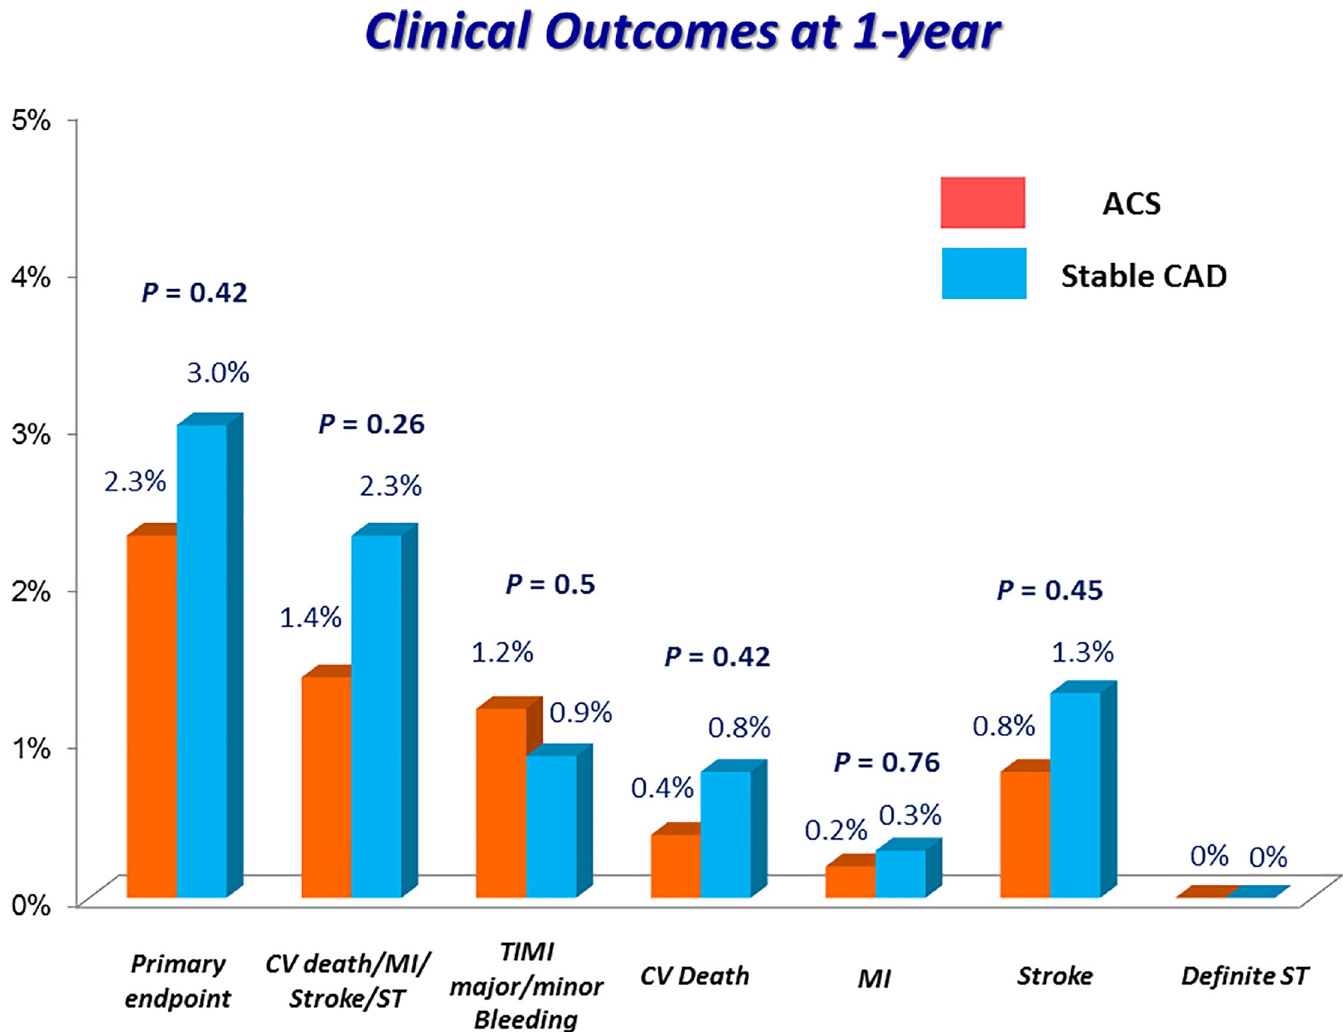
Fig 4. Clinical outcomes at 1-year. Event rates indicated the cumulative 1-year incidence estimated by Kaplan-Meier method. Primary endpoint was defined as a composite of CV death, MI, stroke, definite ST and TIMI major/minor bleeding. ACS, acute coronary syndrome; CAD, coronary artery disease; CV death, cardiovascular death; MI, myocardial infarction; ST, stent thrombosis; TIMI, Thrombolysis in Myocardial Infarction. https://doi.org/10.1371/journal.pone.0227612.g004 Versus Twelve Months of Dual Antiplatelet Therapy After Drug-Eluting Stent Implantation in ST-Elevation Myocardial Infarction) trial, 6-month DAPT was also non-inferior to 12-month DAPT in patients with STEMI undergoing PCI with zotarolimus-eluting stent in terms of the primary endpoint of a composite of all-cause mortality, MI, revascularization, stroke, and TIMI major bleeding at 18 months (4.8% versus 6.6%, P for non-inferiority = 0.004, and P for superiority = 0.26).[18] In contrast, in a network meta-analysis, 3-month DAPT, but not 6-month DAPT, was associated with higher rates of MI or ST as compared to 12-month DAPT in ACS patients, but not in stable CAD patients.[19] In this meta-analysis, data of the 3-month DAPT were derived from the RESET (REal Safety and Efficacy of 3-month dual anti- platelet Therapy following Endeavor zotarolimus-eluting stent implantation), and the OPTI- MIZE (Optimized Duration of Clopidogrel Therapy Following Treatment With the Zotarolimus-Eluting Stent in Real-World Clinical Practice) randomized trials. [20,21] In the